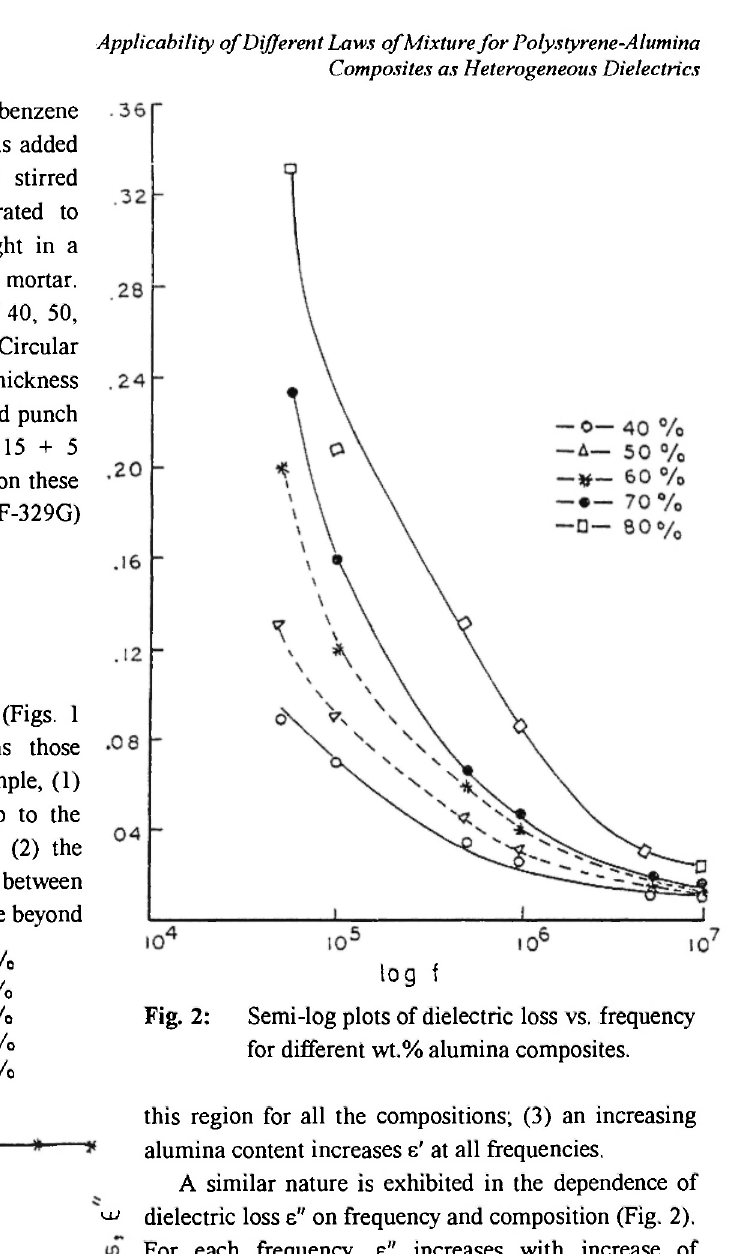
Fig. 2: Semi-log plots of dielectric loss vs. frequency for different wt.% alumina